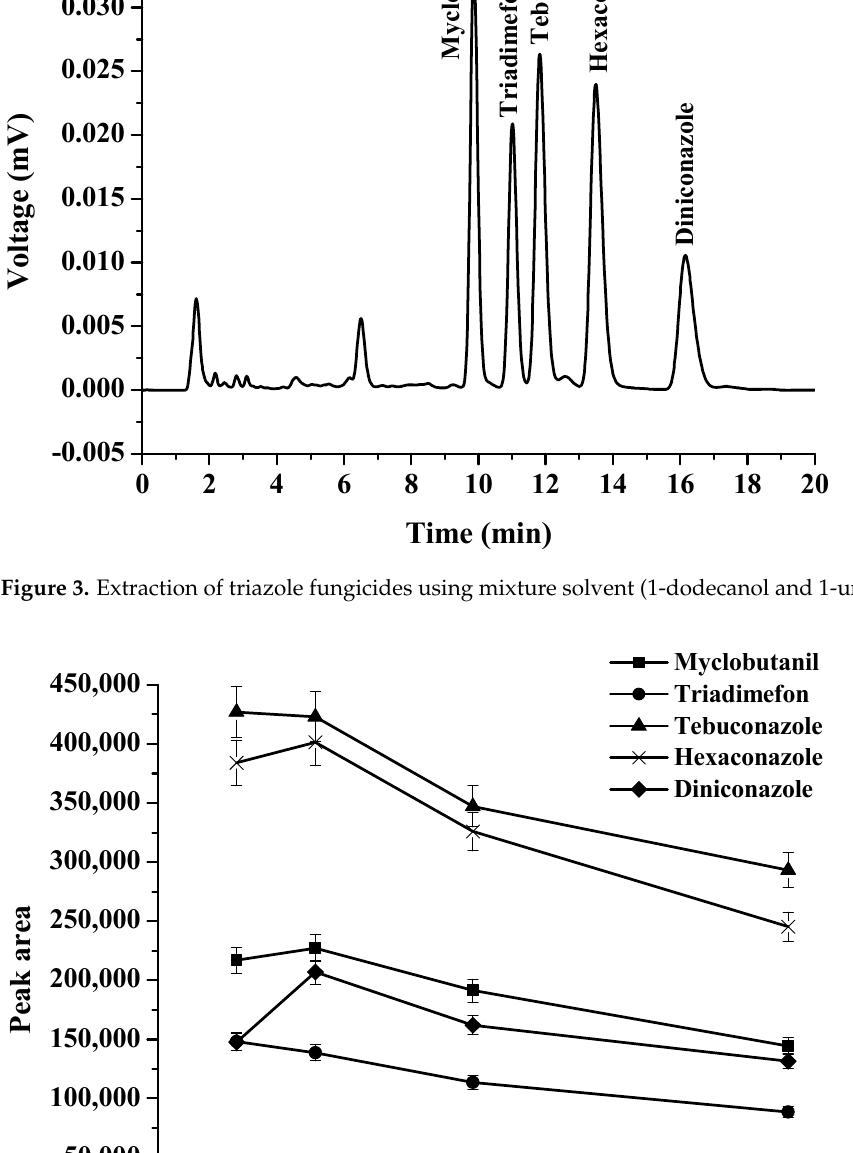
Figure 2. Extraction of triazole fungicides using 1-undecanol as a solvent.